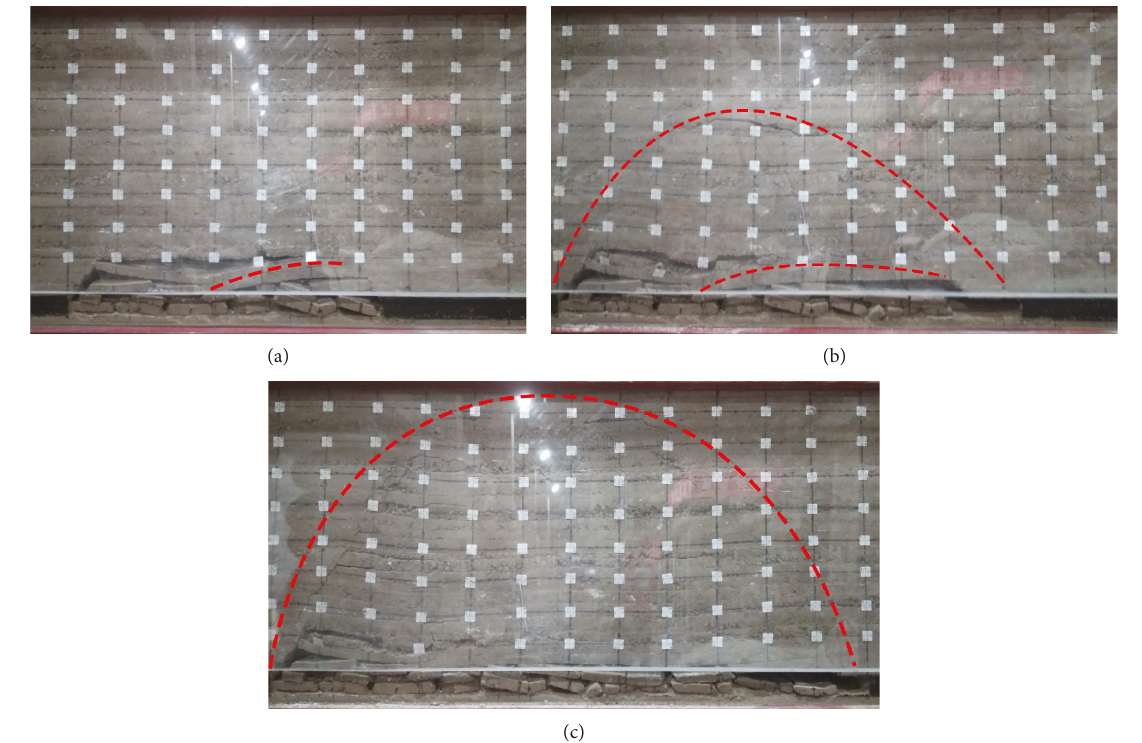
Figure 12: Evolution characteristics of the pressure arch and the caving zone. (a) The pressure arch in the near fi eld. (b) The caving arch zone. (c) The inner boundary of the caving arch.